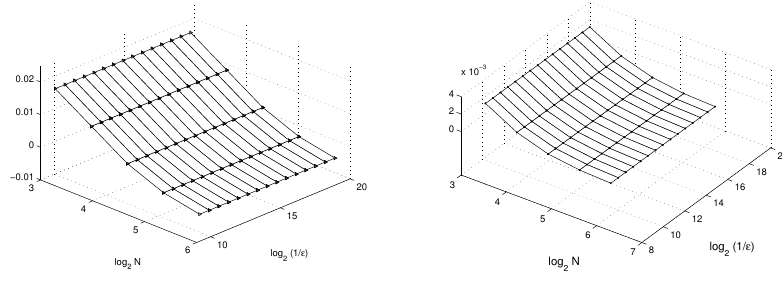
Figure 8. Surface plot of the maximum pointwise errors as a function of N and ε for the scaled discrete derivative components εD 0 Y 1 and εD 0 Y 2 using HDS - II for the Example 2.